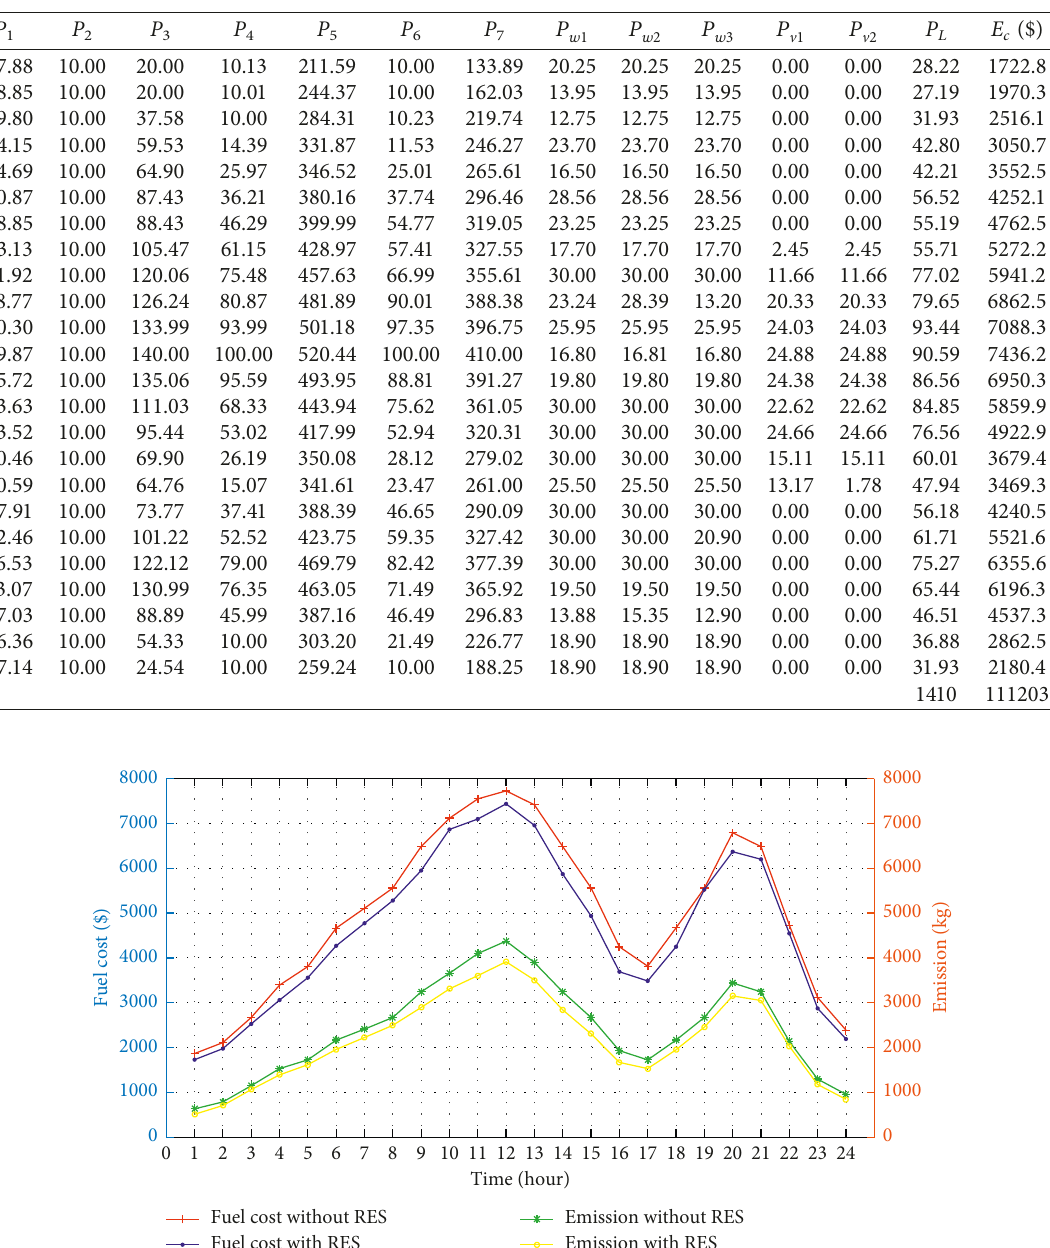
Table 10: Optimal compromise results for Case 3.